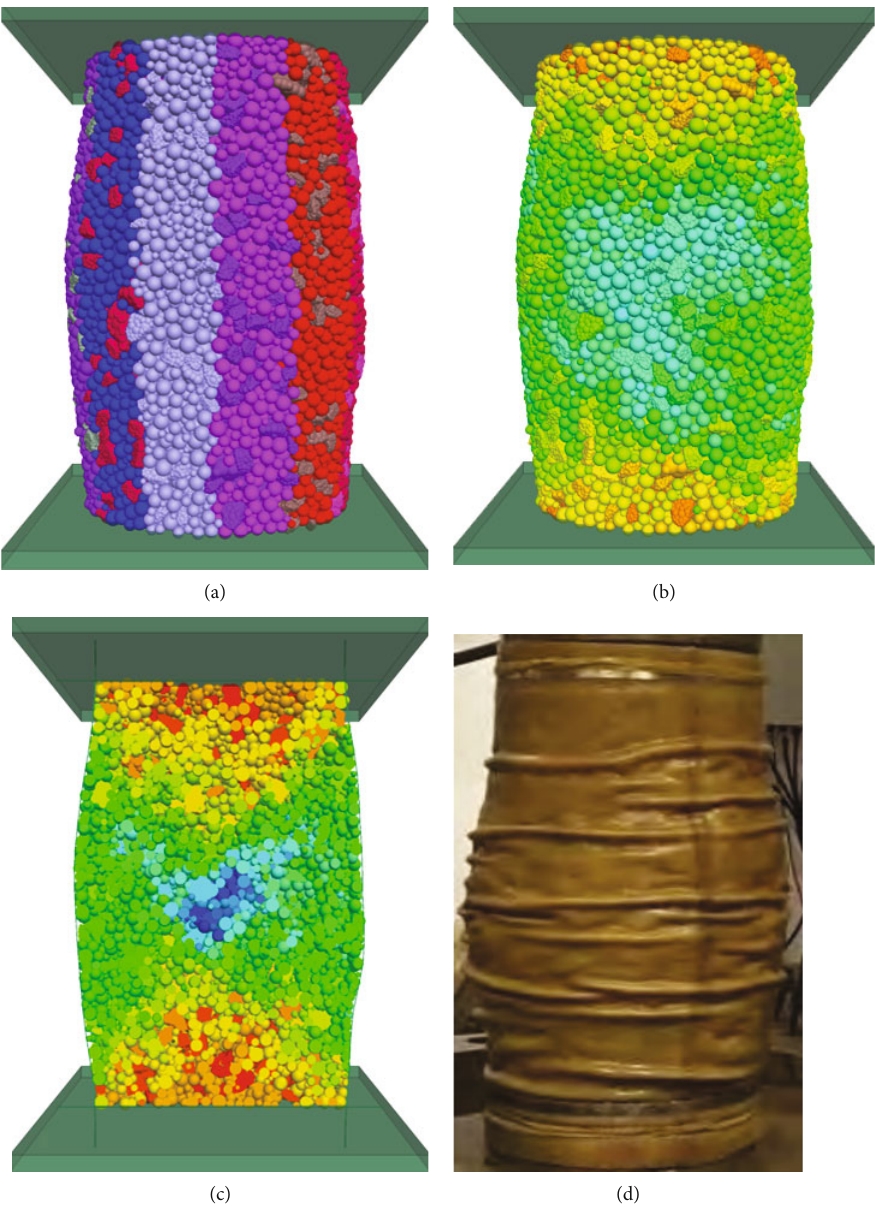
Figure 7: Comparison of failure modes at 15% strain (500kPa): (a) deformed particles; (b) particle displacement; (c) pro fi le of the displacement; (d) experiment